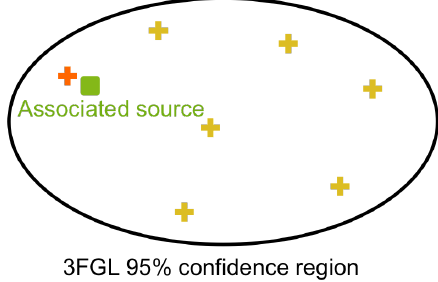
Figure 1. Sketch of the training set creation. Crosses illustrate the possible counterparts (from 1SXPS or